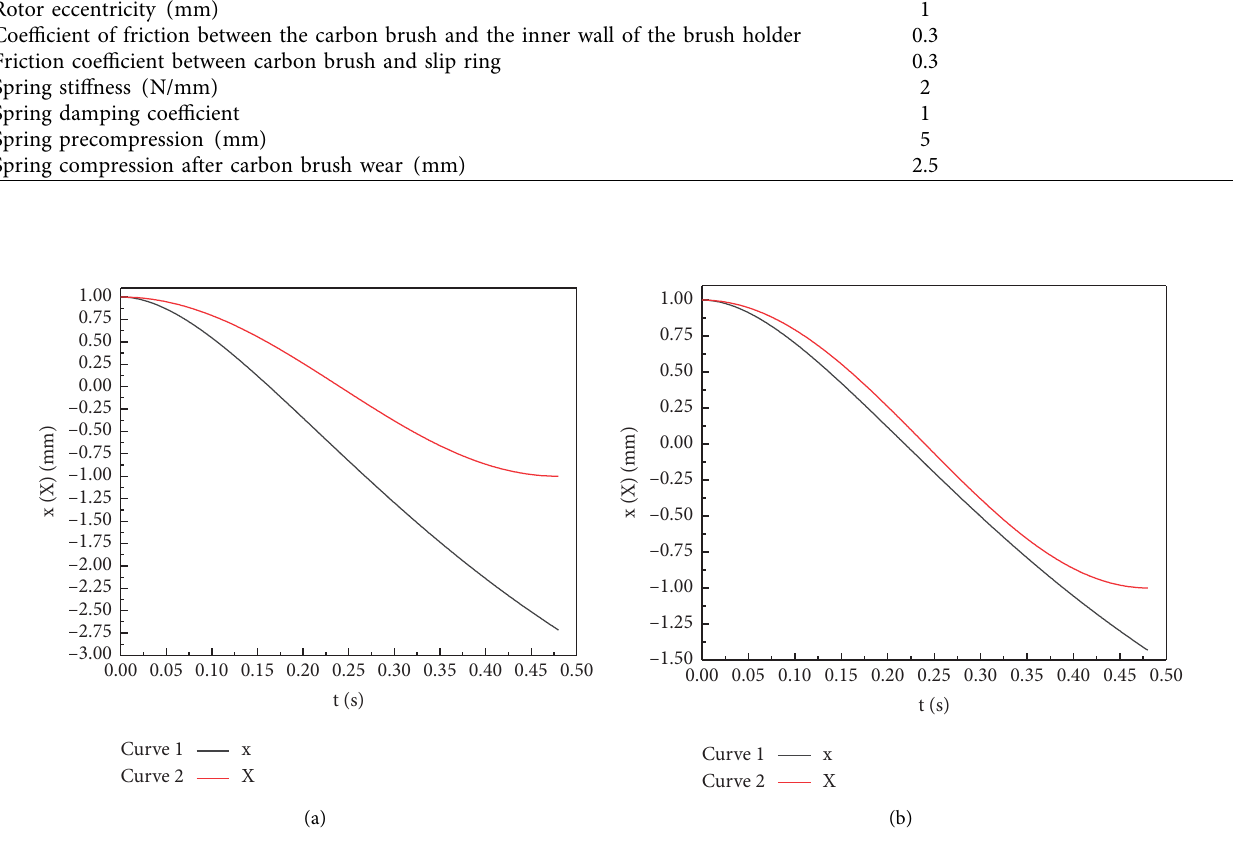
Figure 12: Running track diagram of carbon brush and slip ring during half cycle before and after